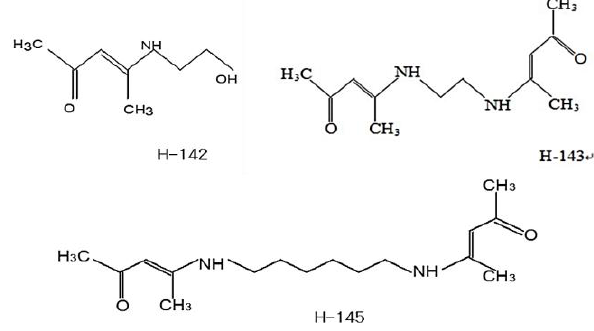
Figure 1. The chemical structure of the collectors